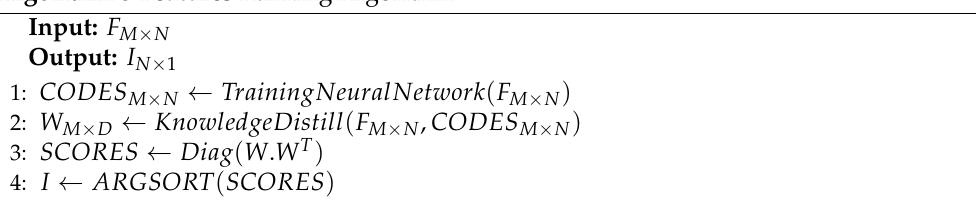
Algorithm 3 Features Ranking Algorithm